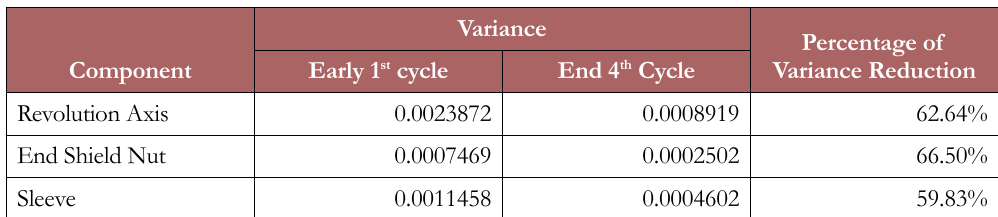
Table 13. Variance Reduction in supplier side